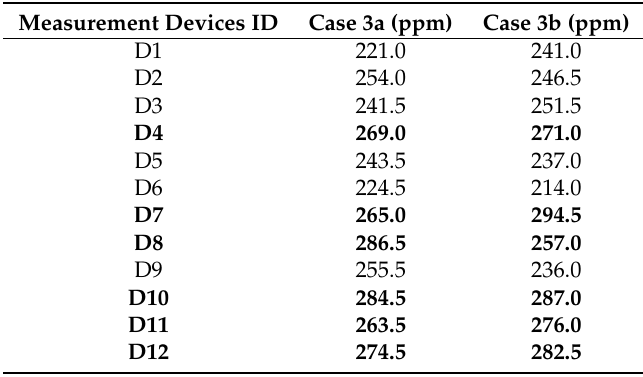
Figure 10. Change in CO 2 concentration in Case3b. DX means Device ID. Table 1. Change in CO 2 concentration at the end of Case